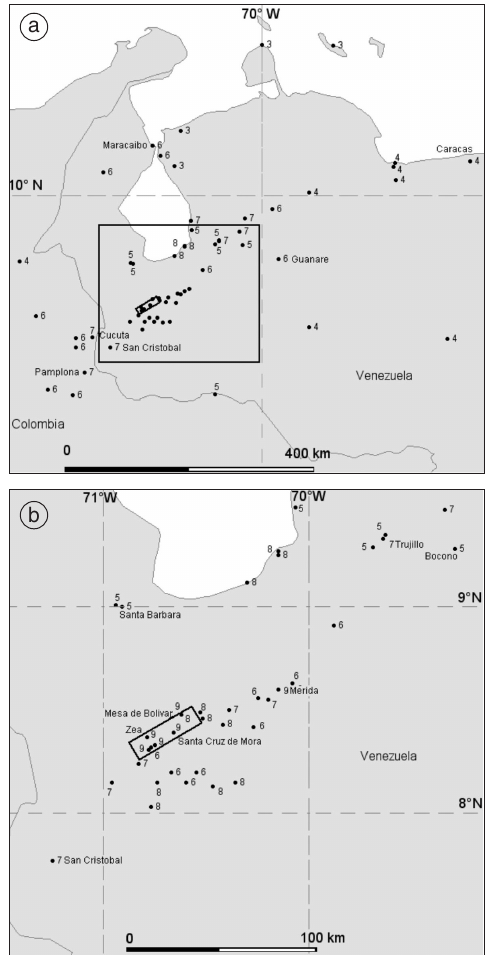
Fig. 4a,b. The 29 April 1894 earthquake in Venezuela: a) 71 intensity data points reported by CERESIS (1985); b) the box represents the source dimension, size and lo- cation obtained from intensity data following the method proposed by Gasperini et al.